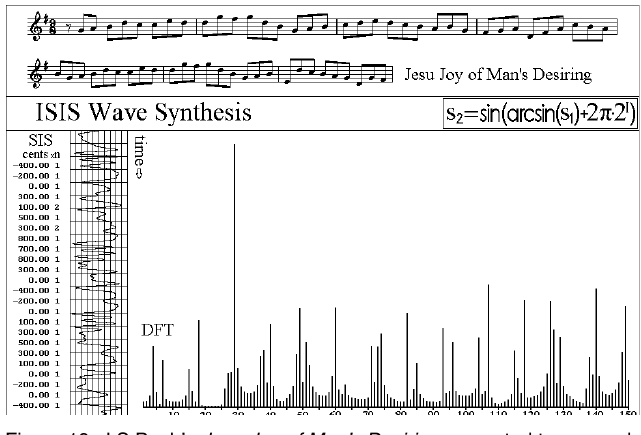
Figure 19: J.S.Bach’s Jesu Joy of Man’s Desiring converted to a sound wave with